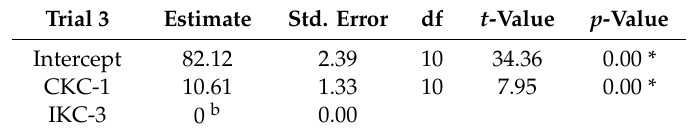
Table 10. The significant di ff erence of mean scores obtained in Trial 3 between CKC-1 and IKC-3. Trial 3 Estimate Std. Error df t -Value p -Value Intercept 82.12 2.39 10 34.36 0.00 * CKC-1 10.61 1.33 10 7.95 0.00 * 0 b